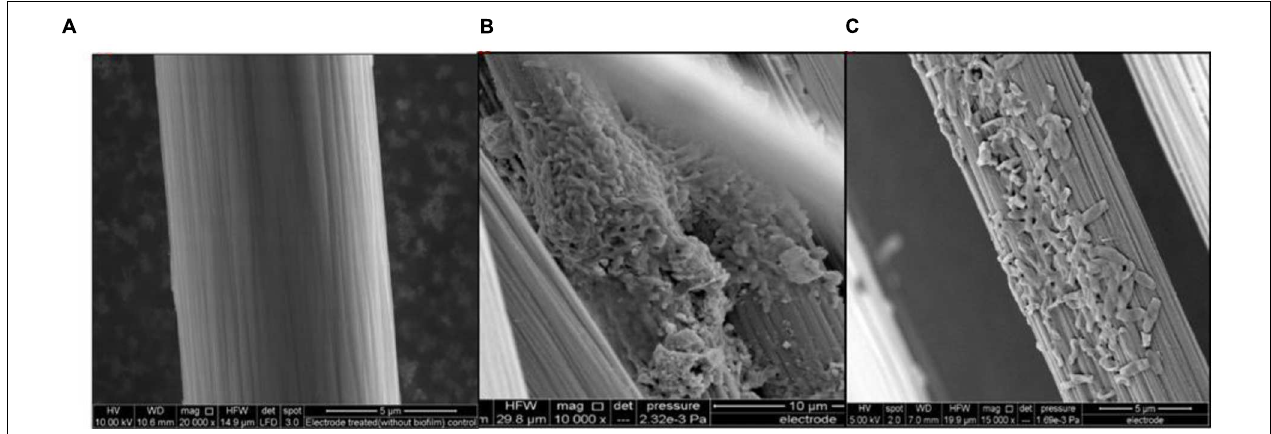
FIGURE 4 | Anode micrographs of R. palustris strain RP2 inoculated acetate-fed MFCs. (A) Treated control anode, (B) Strain RP2- biofilm on graphite surface and (C) Cells with high